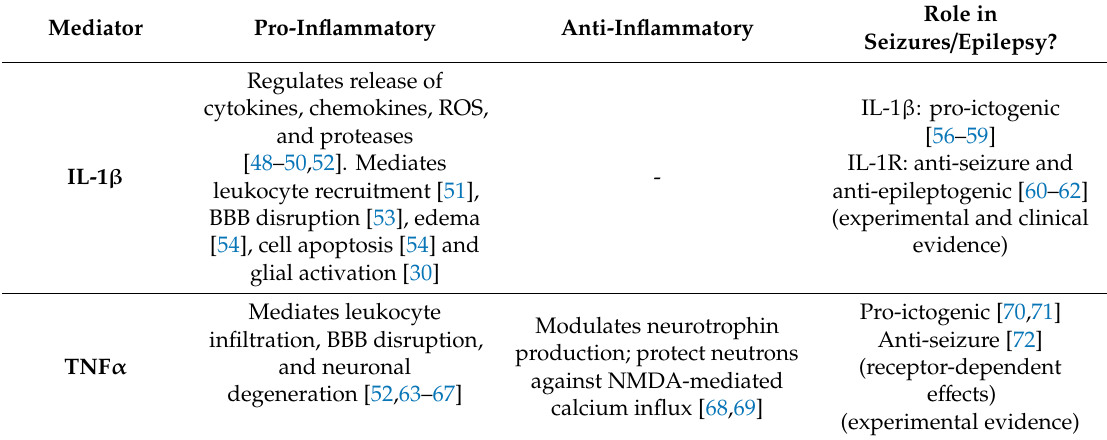
Table 1. Key cytokines and chemokines: evidence of pro- and anti-inflammatory properties after TBI and implications for seizures /